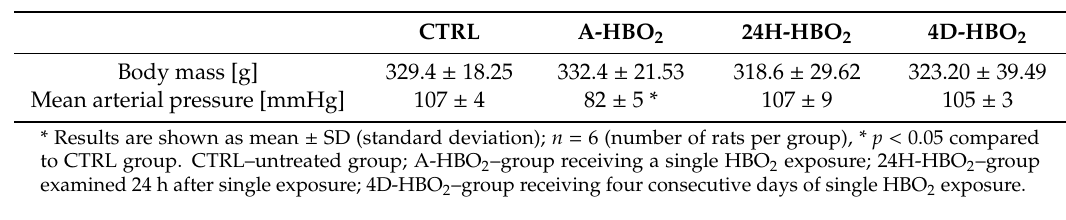
Table 1. Measurements of body mass and mean arterial